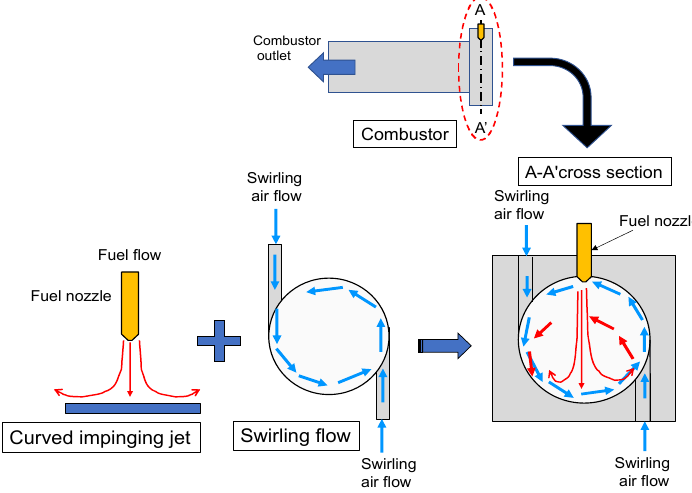
Figure 1. Conceptual diagram of the proposed combustor.